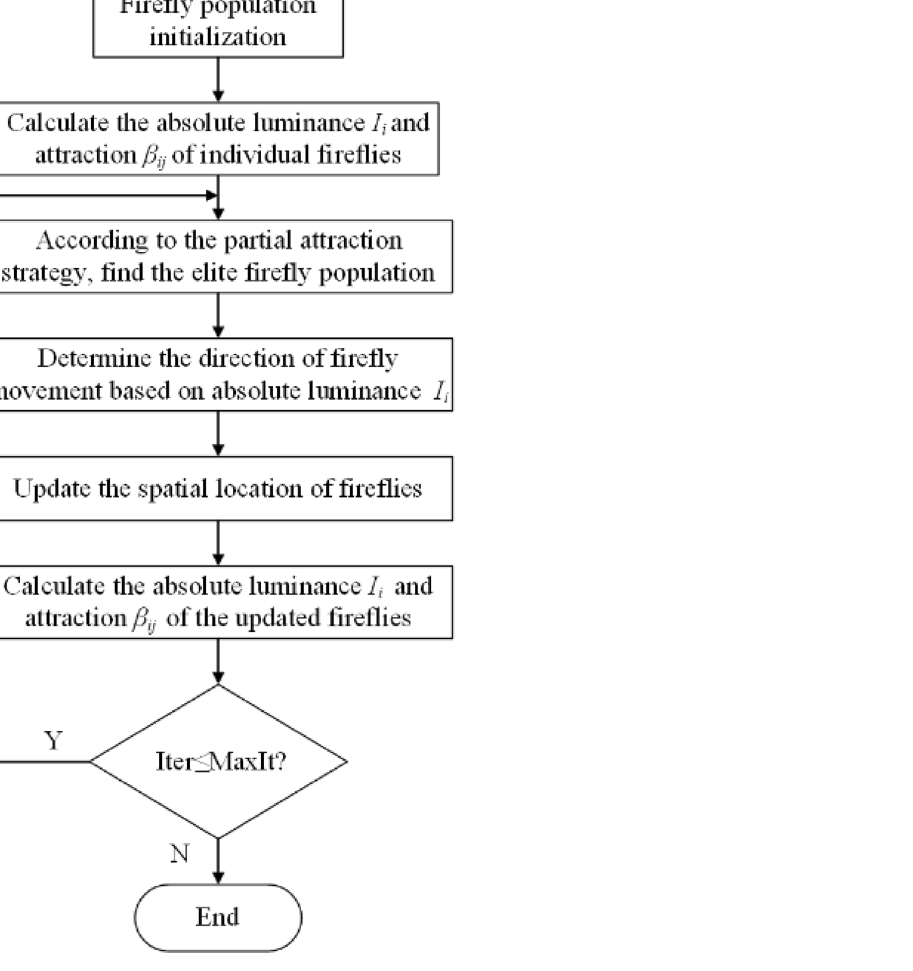
Figure 3. The flow chart of